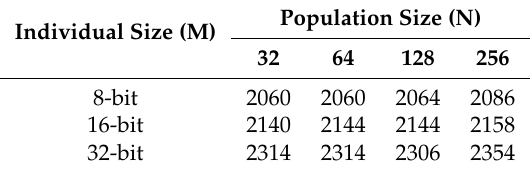
Table 3. Program memory consumption (in bytes) in the slave node, of a total of 32 KB.